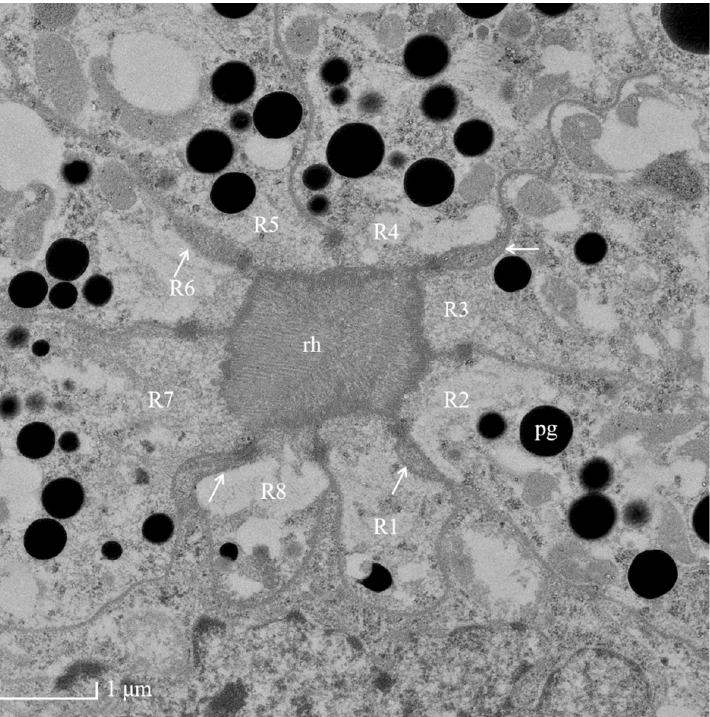
Figure 4. TEM micrograph of the central region of the rhabdom of the ommatidia of female Arge similis showing photoreceptive layer consisting of eight retinular cells (R1 to R8). Four cone roots are located between the retinular cell membranes (arrows). pg: pigment; rh: rhabdom.